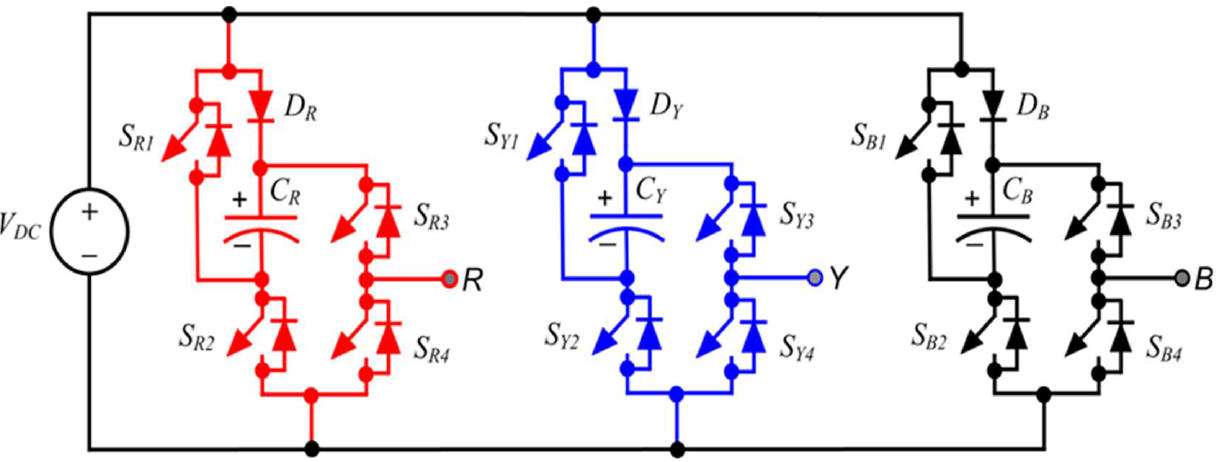
Figure 1. Proposed five level SCMLI topology. Table 1. Different switching modes and their corresponding positive pole voltages for phase leg